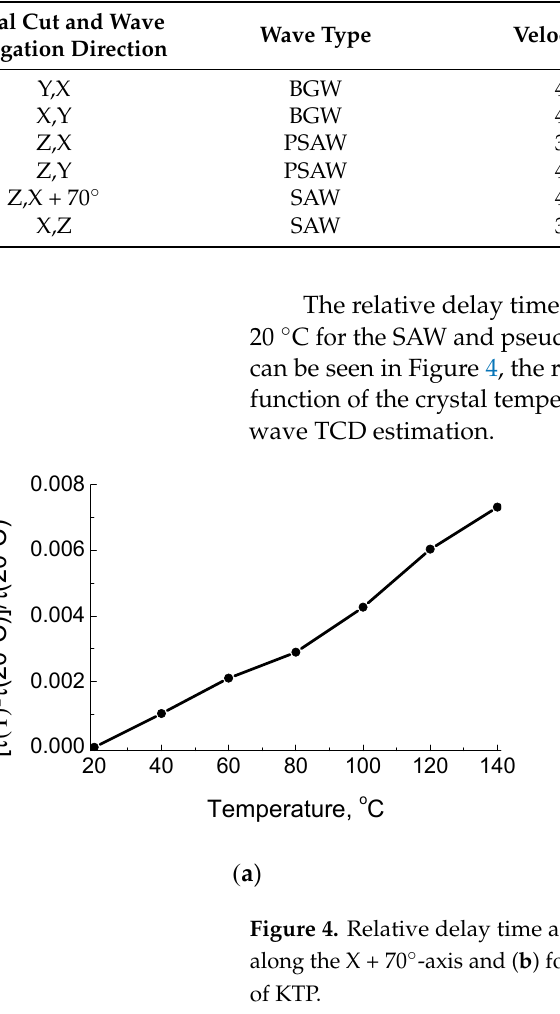
Figure 5. ( a ) Effective permittivity ε eff / ε 0 versus dimensionless slowness V SAW /V and ( b ) surface wave IDT conductance response versus frequency for the uniform IDT having 100 Al electrodes with period λ = 20 μ m and electrode thickness h/ λ = 1% on the Z-cut and the wave propagation direction along the crystal X + 70°-axis. The effective permittivity versus slowness and the IDT conductance as a function of frequency for Z-cut and the pseudo-surface wave propagation direction along the X-axis on the KTP crystal are illustrated in Figure 6. As can be seen in Figure 6b, there is only the pseudo-SAW excitation on the KTP crystal surface. The IDT had 100 Al electrodes with